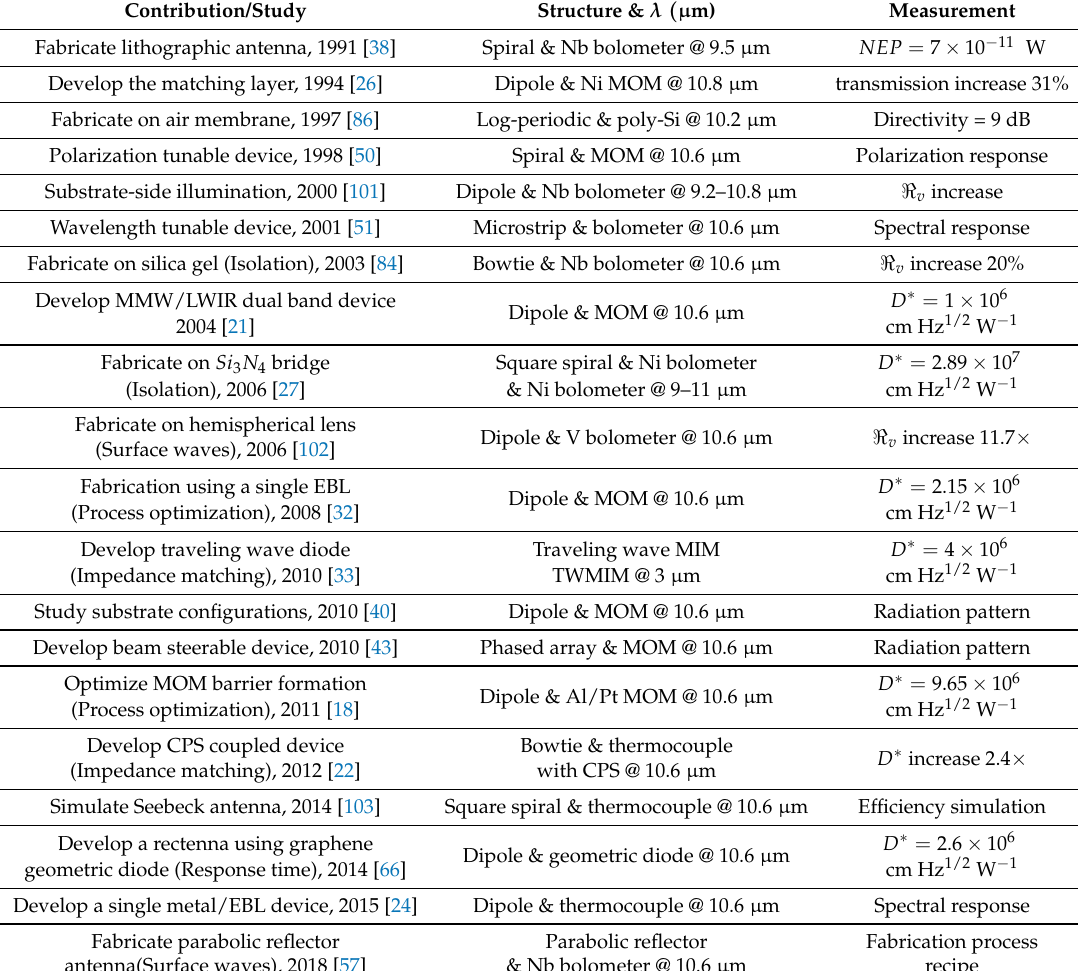
Table 2. Summary of different designs presented in the literature and their